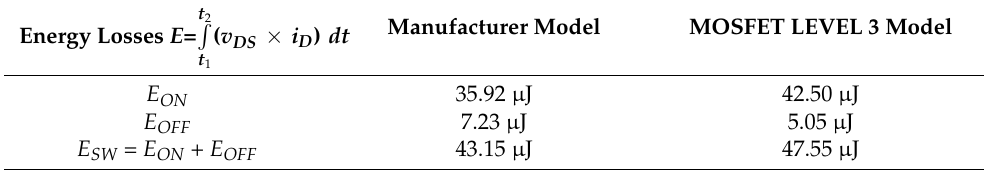
Table 2. Energy losses during switching transients.